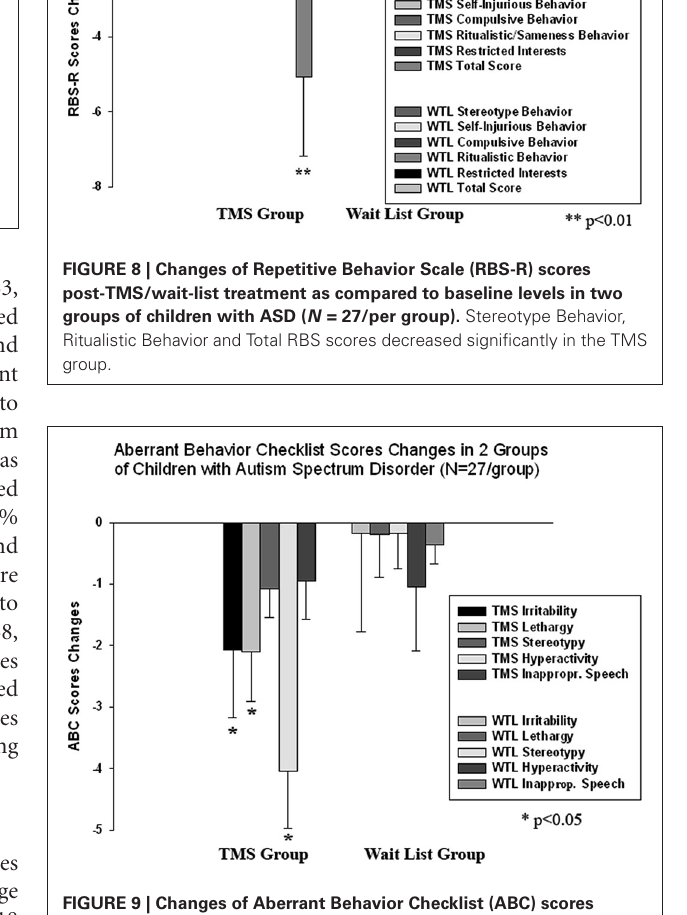
FIGURE 9 | Changes of Aberrant Behavior Checklist (ABC) scores post-TMS/wait-list treatment as compared to baseline levels in two groups of children with ASD ( N = 27/per group). Irritability, Lethargy, and Hyperactivity rating scores decreased significantly